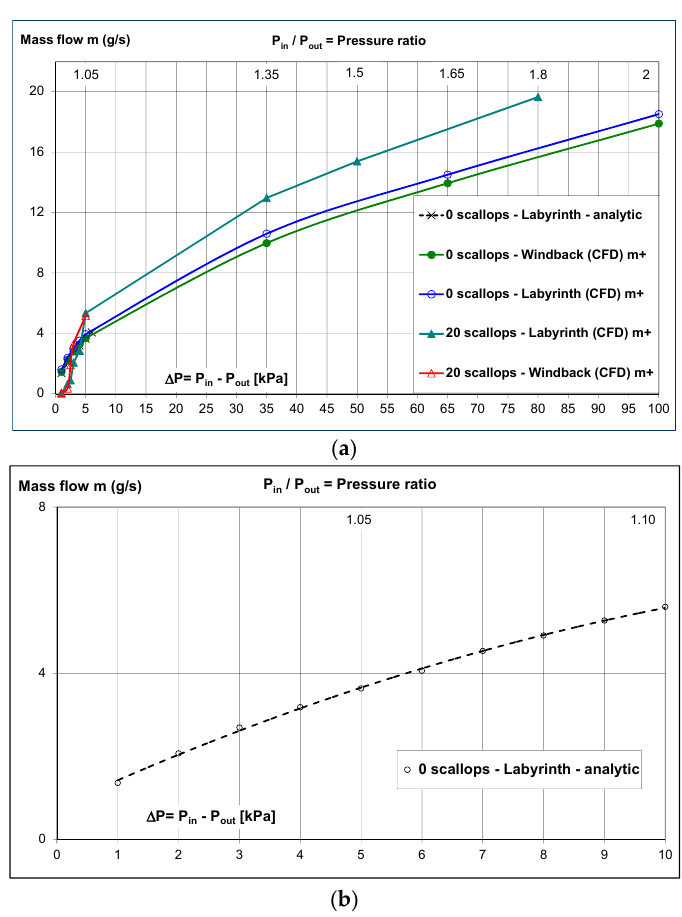
Figure 11. ( a ) Effective mass flow m + through different seal/rotor types as a function of the pressure ratio at 15,000 rpm and s = 0.3 mm; ( b ) Effective mass flow m + through the labyrinth seal as a function of the pressure ratio at 15,000 rpm and s = 0.3 mm.